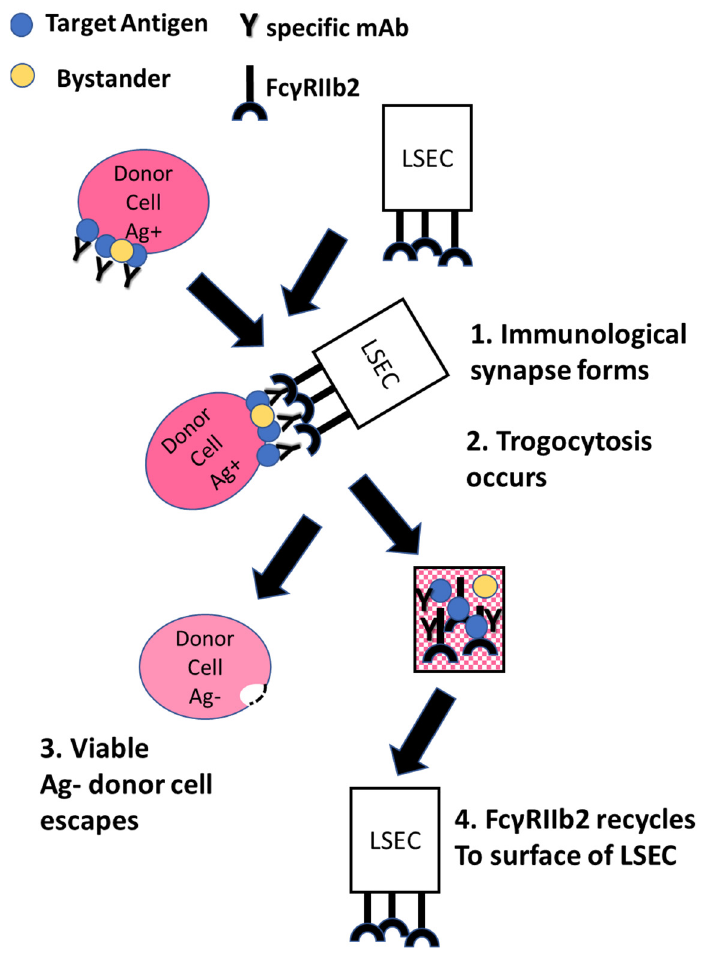
Figure 1. Schematic representation of Fc γ RIIb2-mediated trogocytosis. 1. A circulating IgG-opsonized target cell encounters LSEC. 2. An immunological synapse forms between the cell-bound immune complex and Fc γ RIIb2 on the surface of the LSEC. 3. The immune complex, cell membrane, and some bystander proteins located in proximity to the target antigen are transferred from the target cell to the LSEC and internalized. The target cell escapes with loss of varying amounts of immune complexes and loss of some membrane. 4. Fc γ RIIb2 recycles to the surface of the LSEC, ready to repeat the cycle.